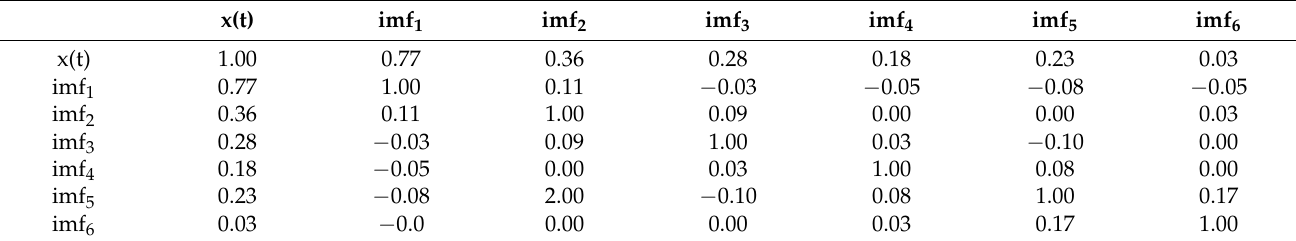
Table 1. Pearson correlation coefficient matrix among original signal and the IMFs.